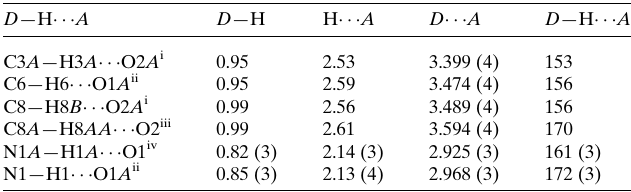
Table 1 Hydrogen-bond geometry (A˚ , (cid:4) ).